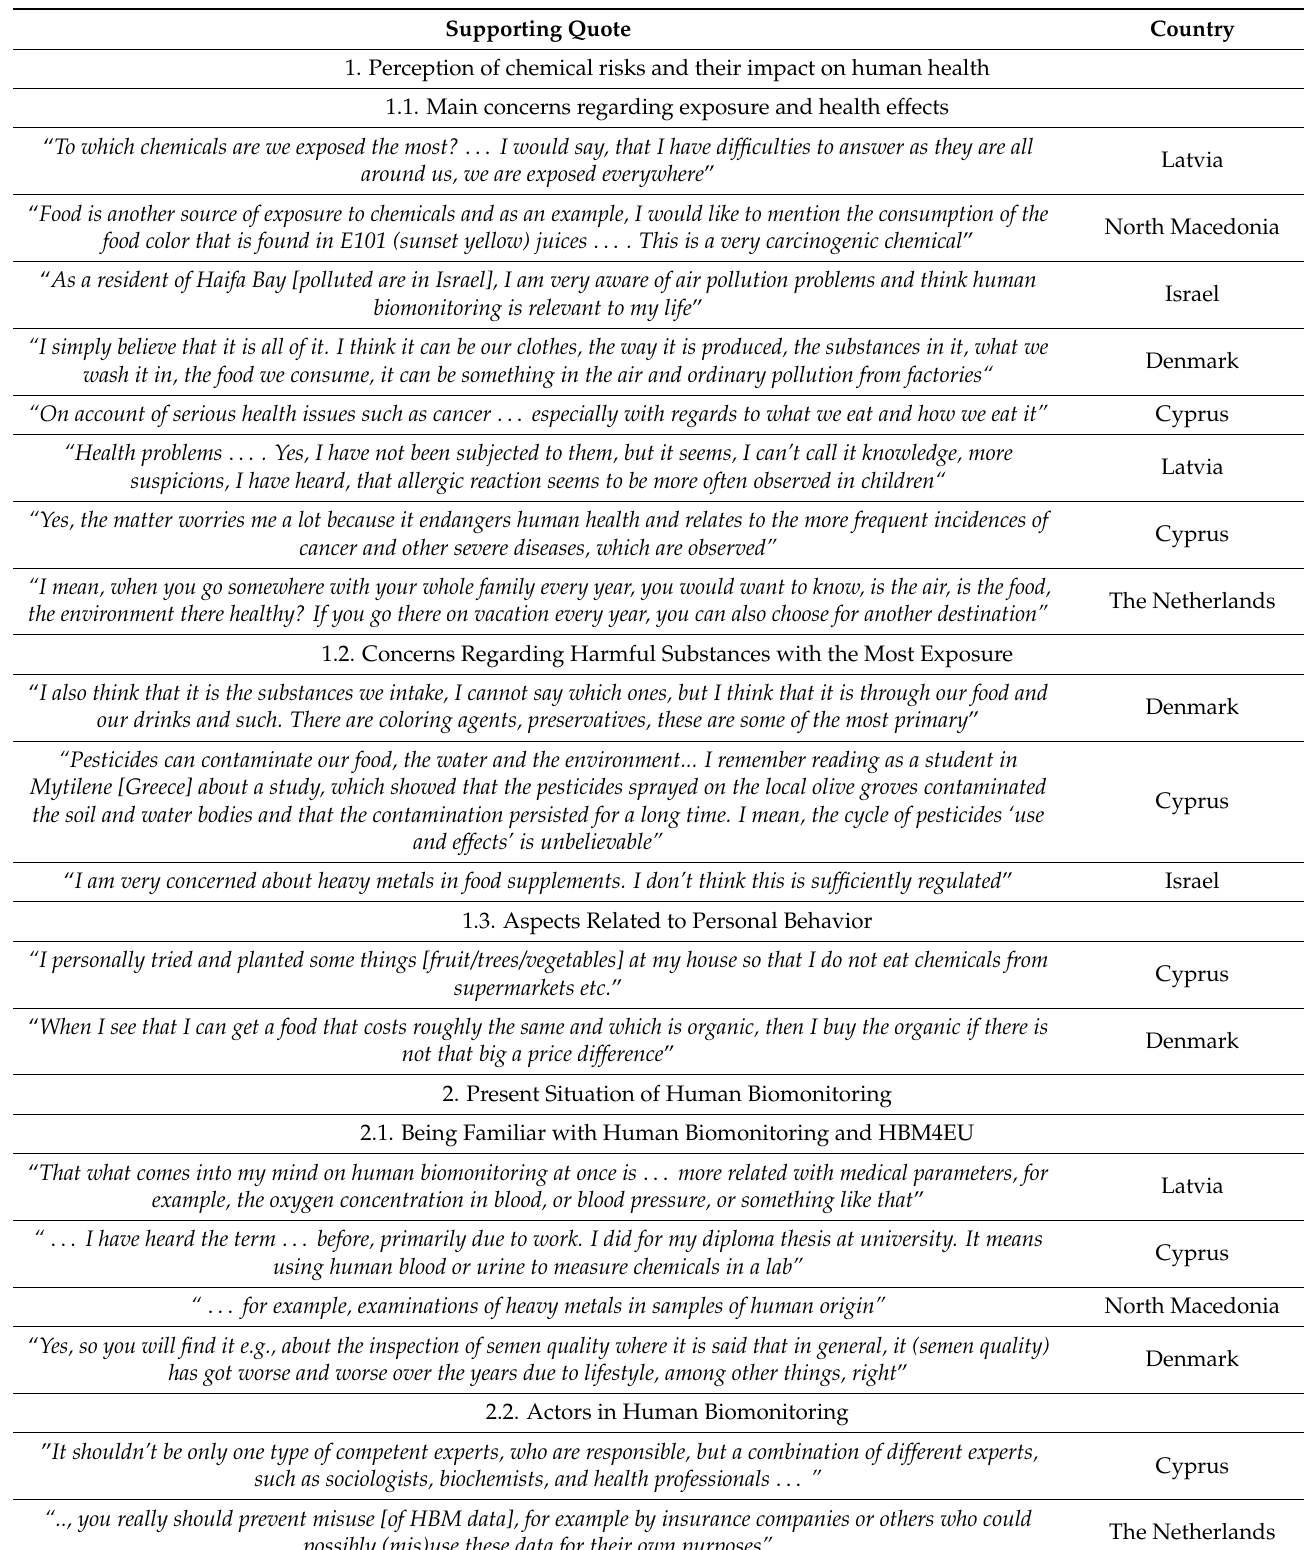
Table A1. The most relevant quotes to support the